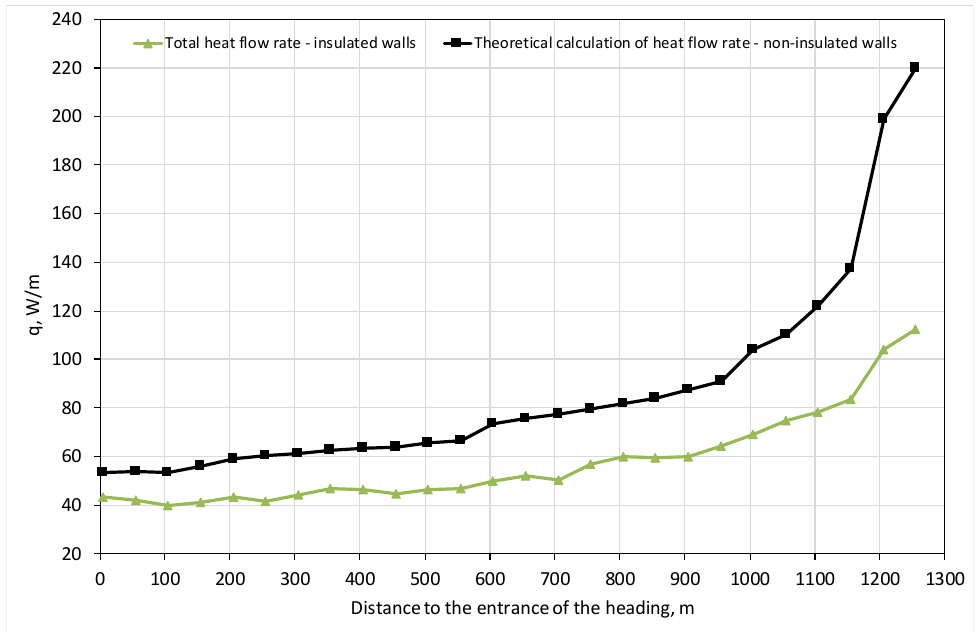
Figure 8. Comparison of the calculation results of heat flow rate in an insulated heading with the theoretical heat flow rate without insulation.